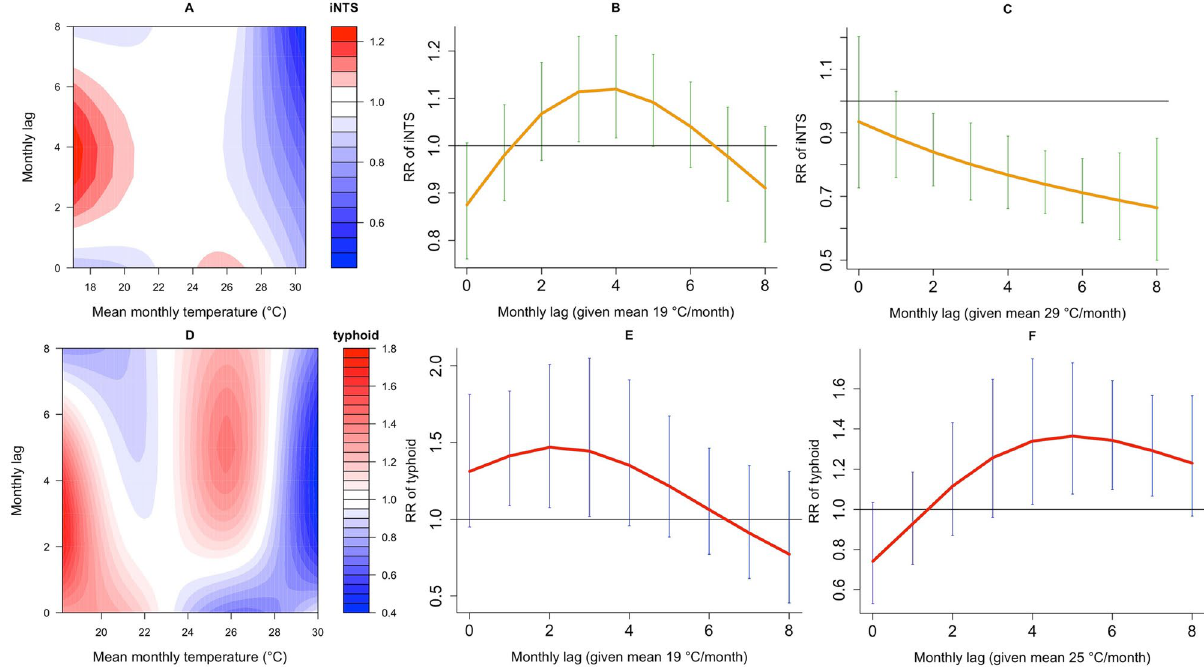
Figure 5. Relative risk (RR) of invasive Salmonella diseases, given temperature exposures and monthly lags. Contour plot of temperature-lag-nontyphoid (iNTS) ( A ) relative to baseline mean monthly temperature conditions of 23 °C at lags between 0 and 8 months, and lag-iNTS curve plots at 19 °C ( B ) and 29 °C ( C ) of temperature with 95% Confidence Intervals; Contour plot of temperature-lag-typhoid ( D ) relative to baseline mean monthly temperature conditions of 23 °C at lags between 0 and 8 months, and lag-typhoid curve plots at 19 °C ( E ) and 25 °C ( F ) of temperature with 95% Confidence